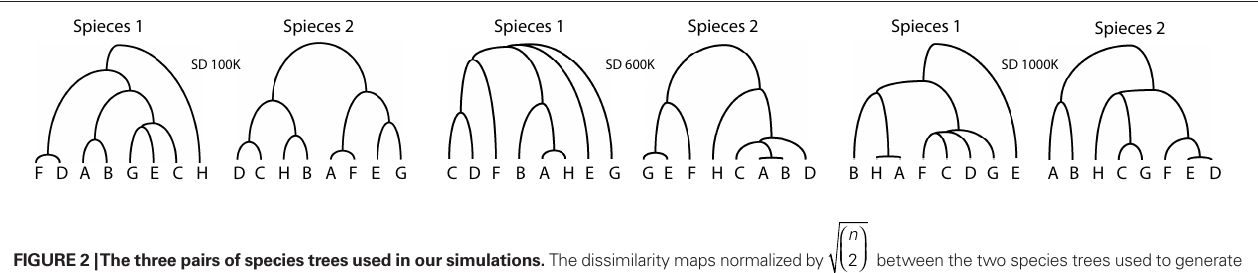
Figure 2 | The three pairs of species trees used in our simulations. The dissimilarity maps normalized by gene trees for our simulations are 0.4333 for 1,000,000 species depth, 0.2672 for 600,000 species depth, and 0.046 for 100,000 species depth.